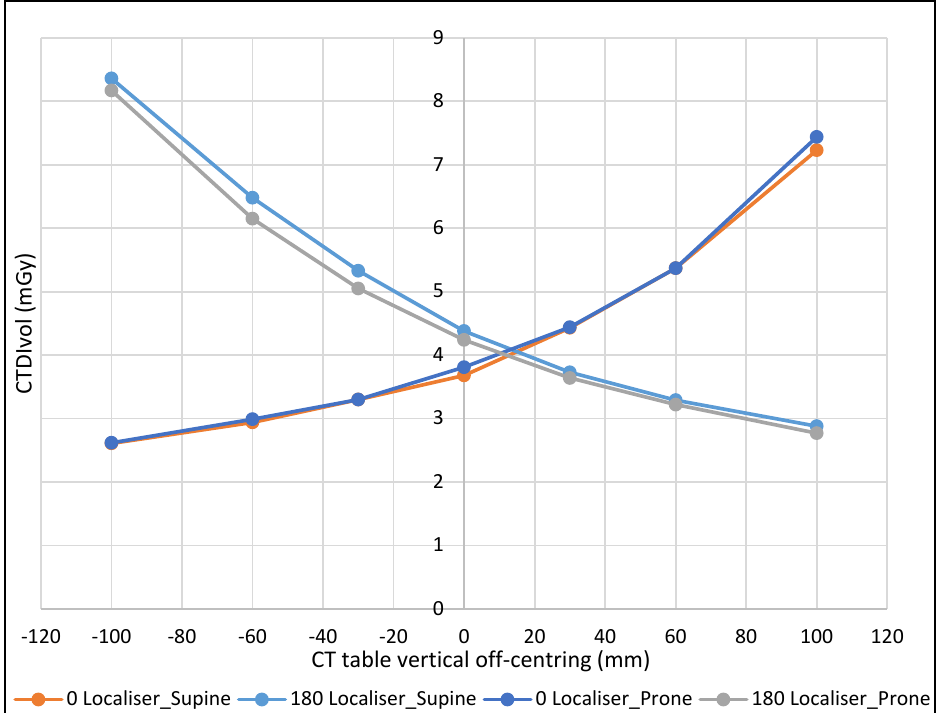
Figure 6. The effect of CT table off-centring on CTDI vol with different phantom positions and localiser directions at 120 kVp.